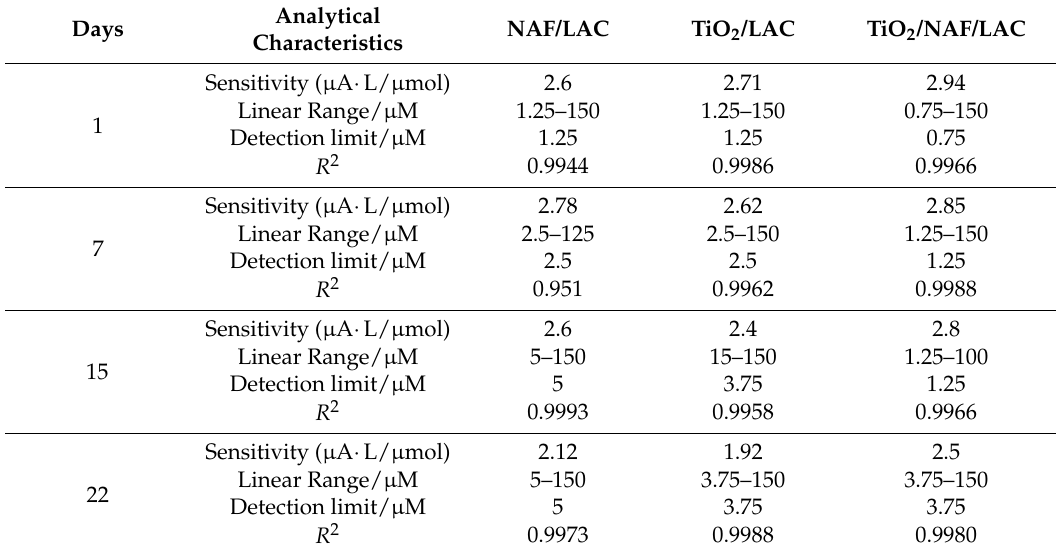
Table 1. The sensitivity, linear range and detection limit of enzyme biosensors were tested on the first, seventh, 15th and 22nd